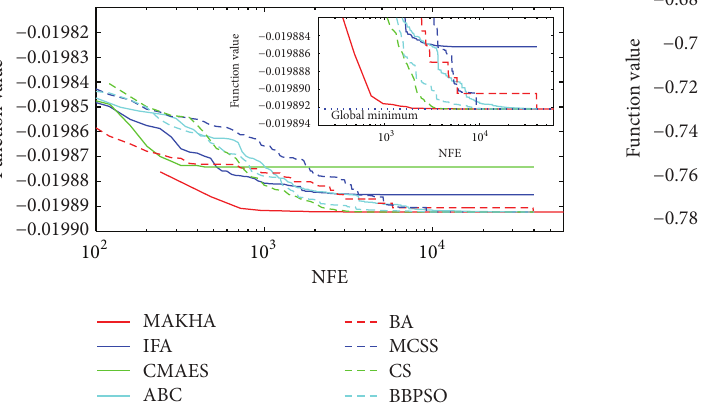
Figure 7: The evolution of the mean best value calculated via the eight metaheuristics versus NFE for problem G8.